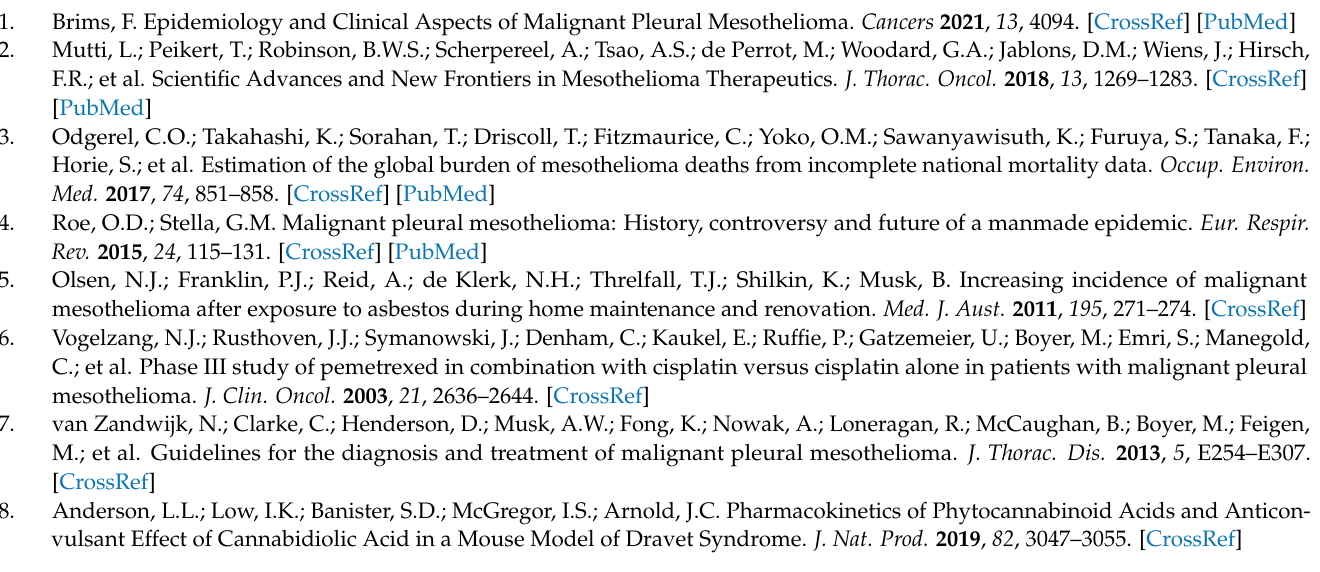
Table S6: CBG comparisons IPA